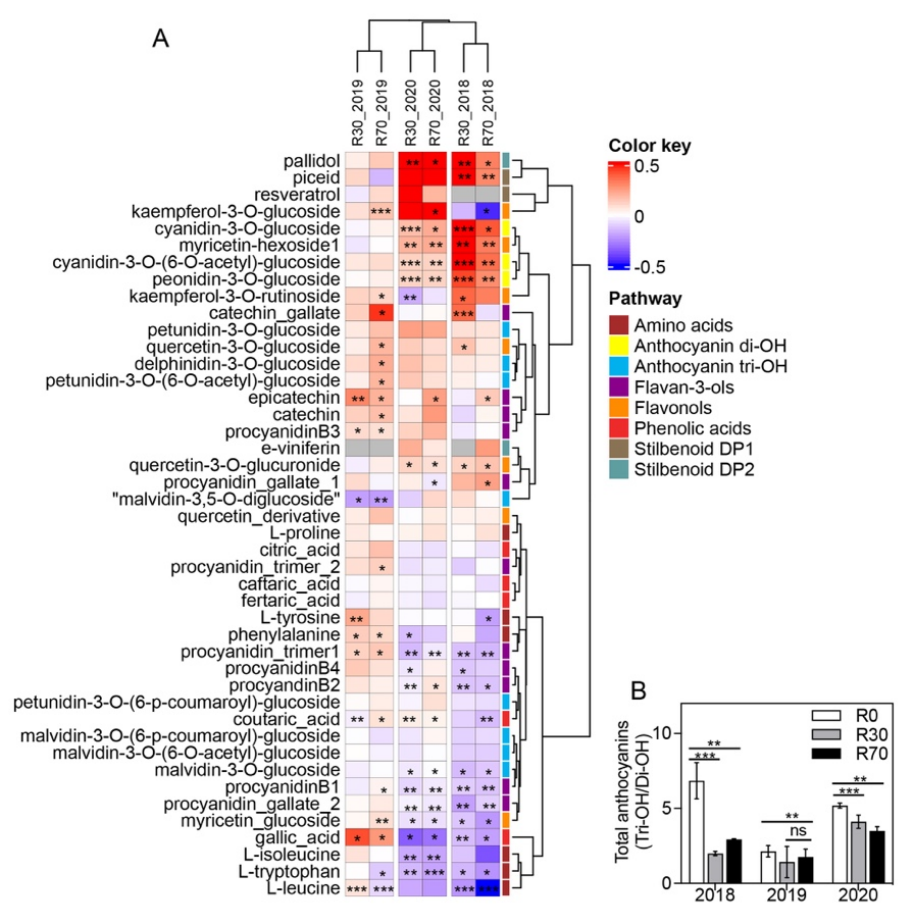
Figure 7. Metabolite changes in mature grape berries from Douro region subjected to different irriga- tion conditions in 2018, 2019, and 2020 vintages. ( A ) Heatmap shows the levels of individual amino acids, phenolic acids, stilbenoids, flavonols, flavan–3–ols, anthocyanins Di–OH, and anthocyanins Tri– OH. Values are the logarithmic transformed fold change (R30/R0 and R70/R0) of berry compounds from Touriga Nacional. Columns represent the means ± SD ( n = 4). ( B ) Ratio of total Tri–OH/Di–OH anthocyanins for the three vintages. Asterisks denote the significance levels as comparing R30 to R0 and R70 to R0) of berry compounds and anthocyanins ratio: * p ≤ 0.05; ** p ≤ 0.01; *** p ≤ 0.001; ns = non–significant.